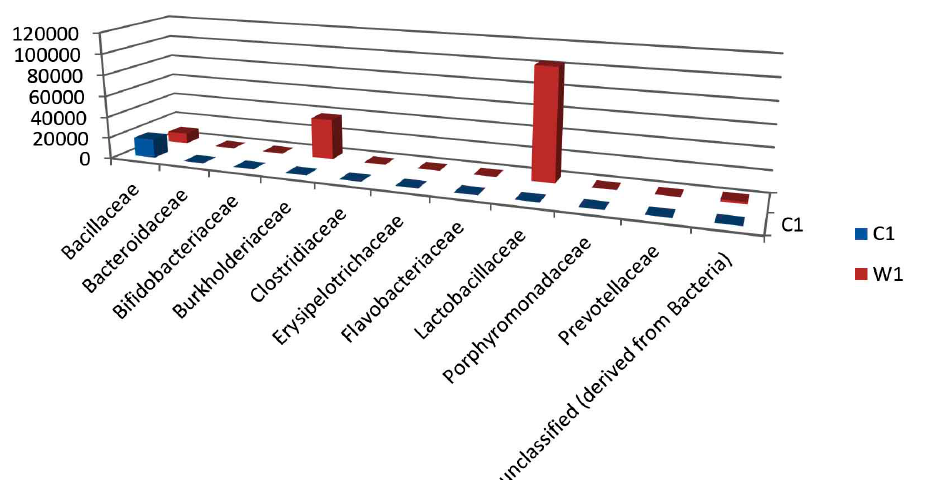
Fig. 4. Bar plot of Genus level distribution